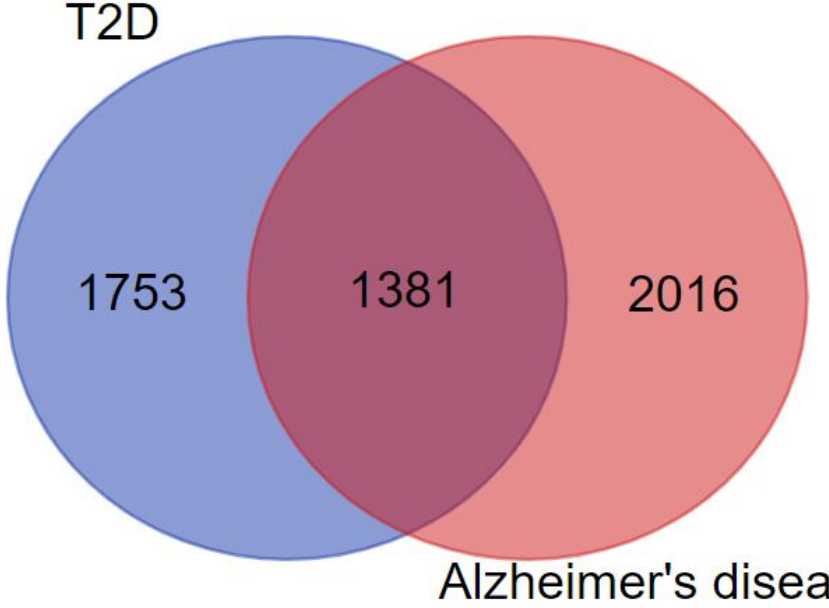
Figure 1. Venn diagram representing the interaction of T2D with AD.